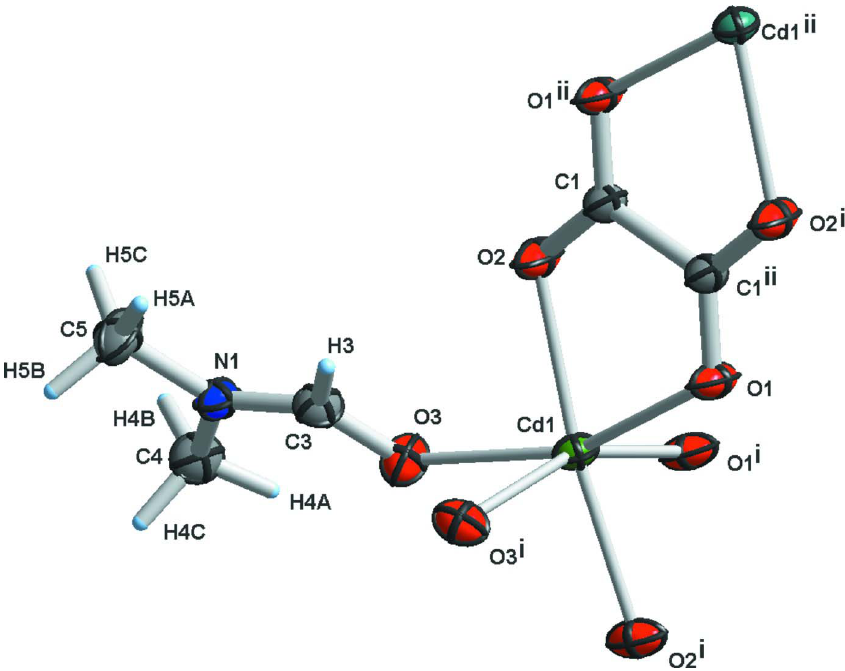
Figure 1 Perspective drawing showing the atom-numbering scheme and atomic displacement ellipsoids at the 50% probability level for non-H atoms. Symmetry codes: (i) - x + 1, y , - z + 1/2; (ii) - x + 1, - y , - z .